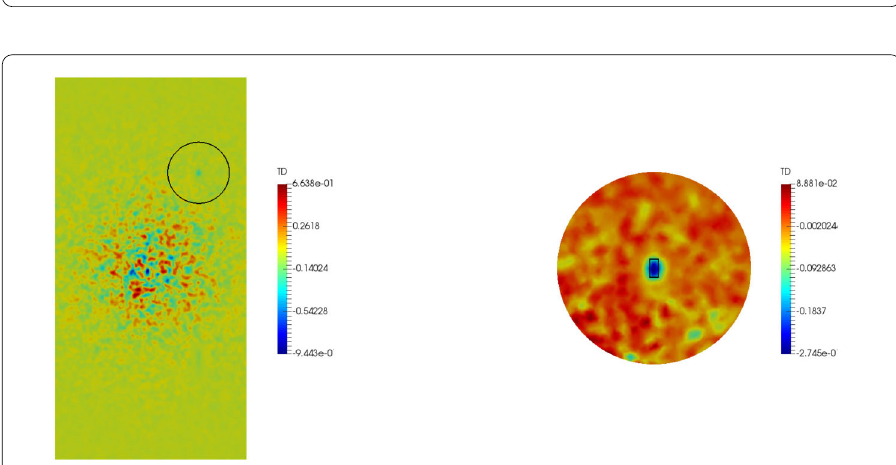
Figure 8 Topological derivatives on Γ front for a single experiment. Left: topological derivative corresponding to ω = 0.8 Hz. Right: topological derivative corresponding to ω = 2 Hz. Any possible detection of the defects is due to cognitive bias